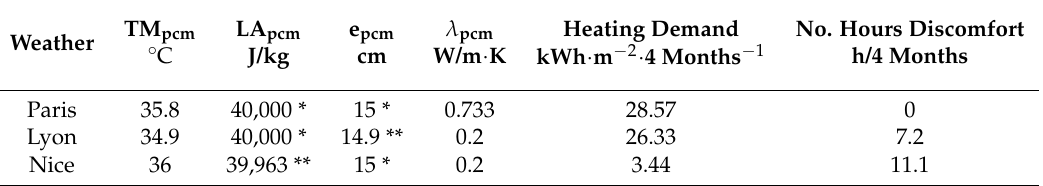
Table 9. Optimal parameters, for three weather datasets, from the optimization of the single-objective